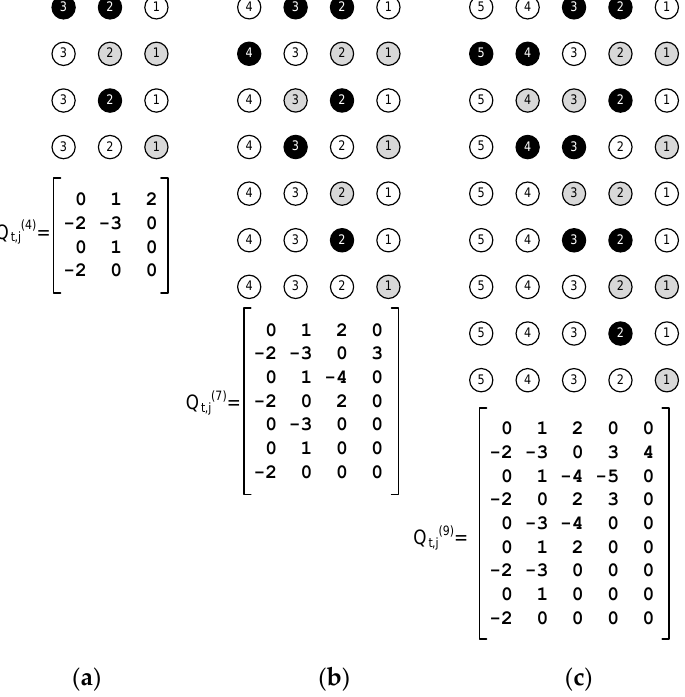
Figure 8. Simple fair schedule (one frame) examples for different string network sizes ( 𝑁 ): ( a ) 𝑁 = 3 ( 𝑇 = 4), ( b ) 𝑁 = 4 ( 𝑇 = 7), and ( c ) 𝑁 = 5 ( 𝑇 = 9). The 𝑄 matrix is shown for each case. For 𝑁 = 2 , the solution is trivial with period 𝑇 = 1 . The three states for the nodes are represented keeping the convention used in Figures 5 and 6.